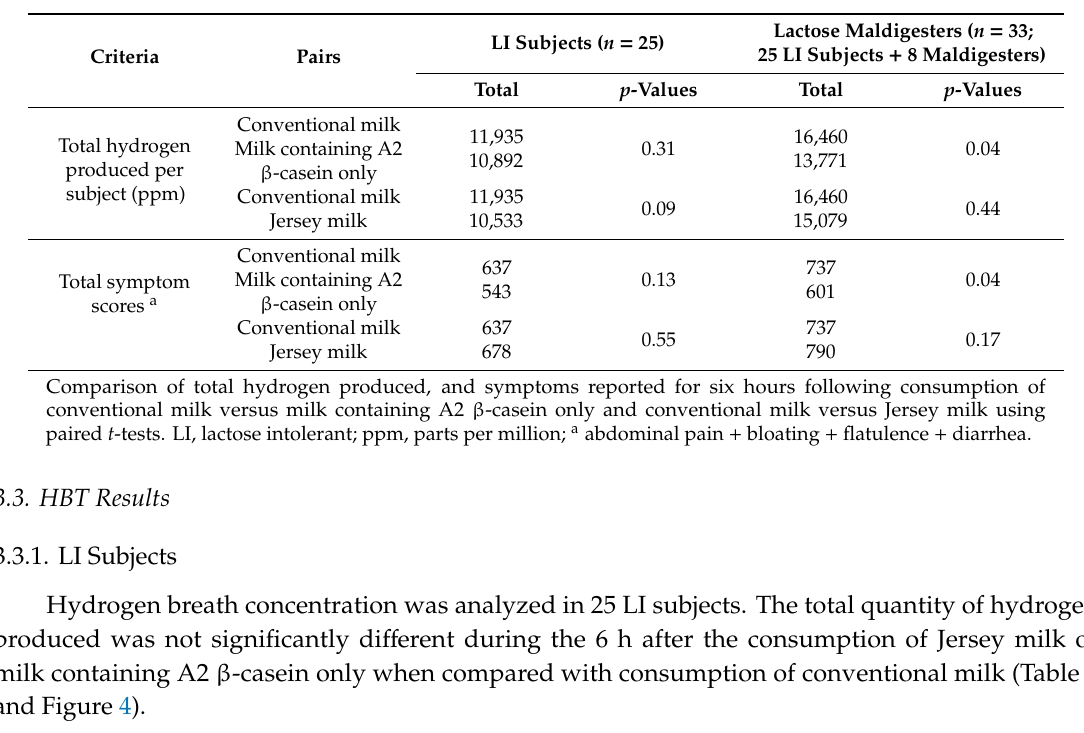
conventional milk.